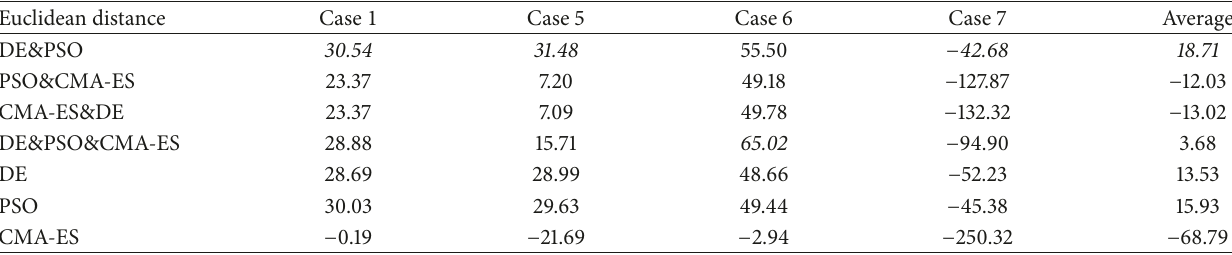
Table 14: Performance improvement with respect to Euclidean distance